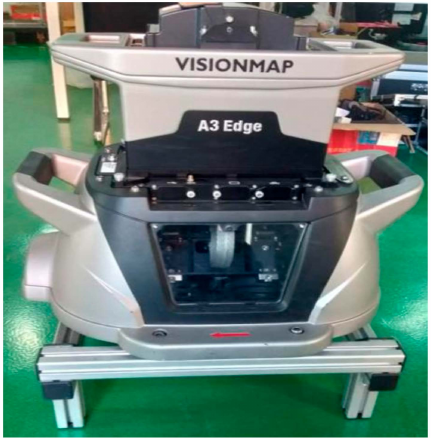
Figure 1. VisionMap A3.